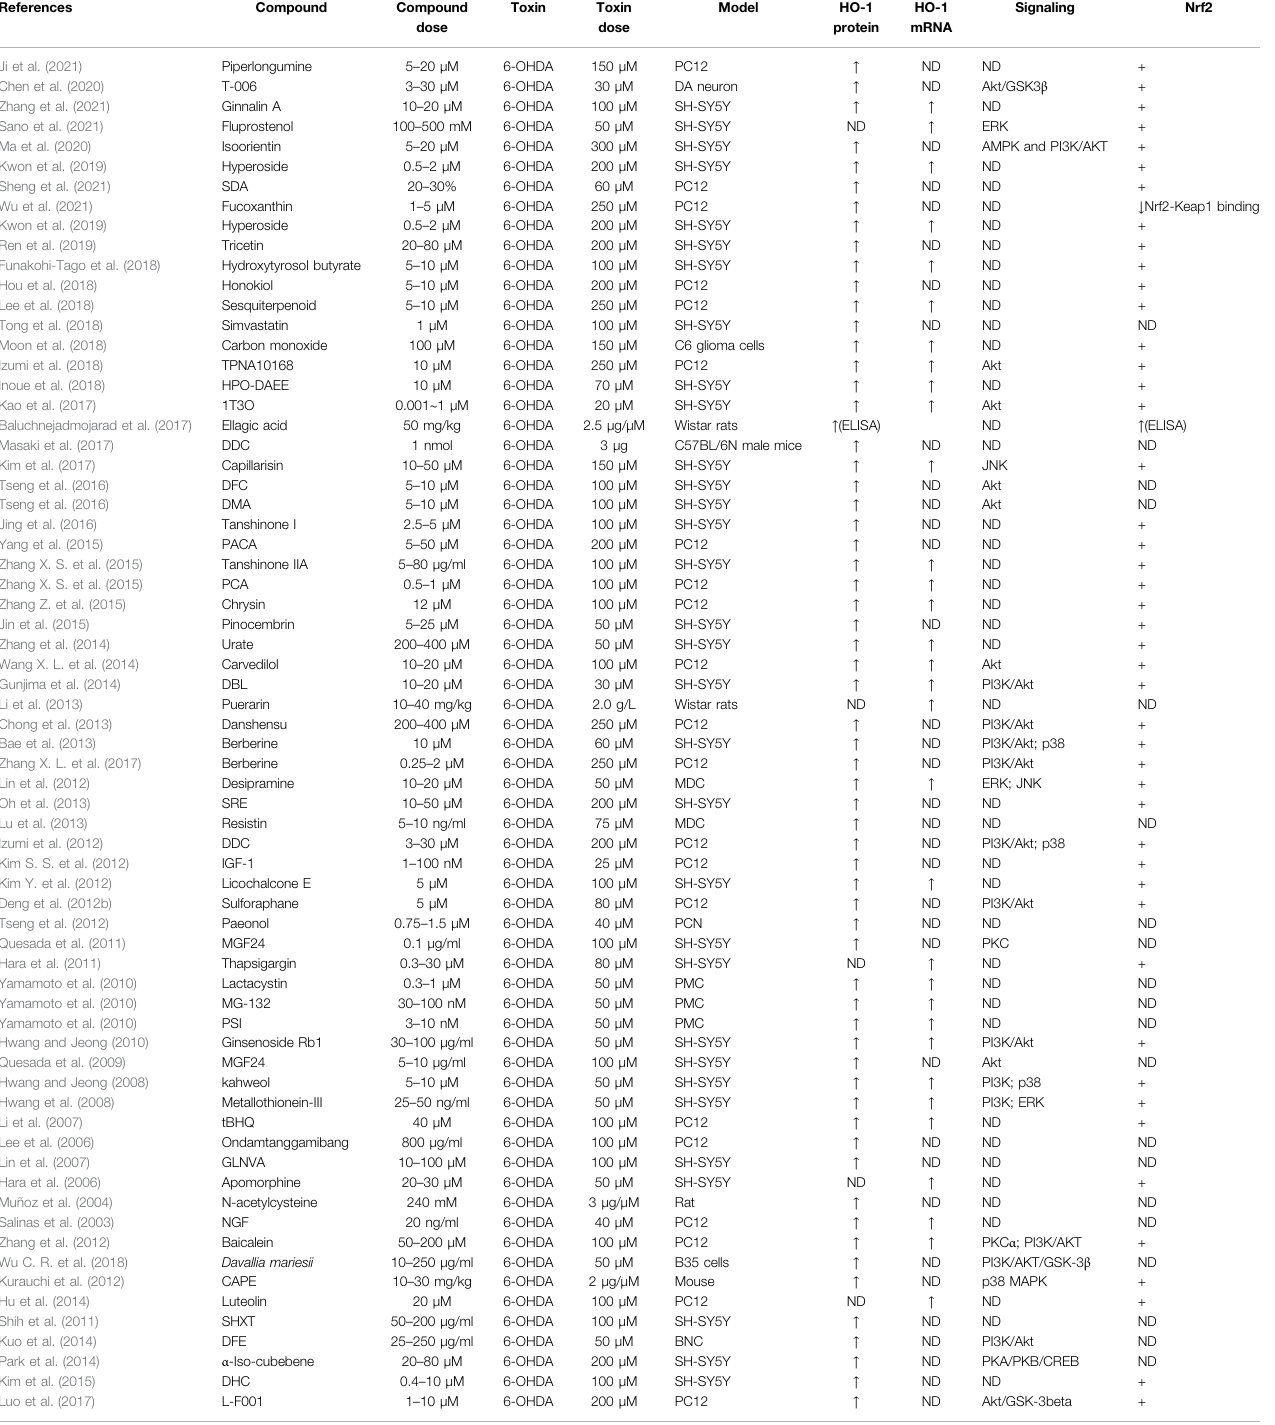
TABLE 7 | Summary of the experimental studies involving HO-1 inducer against 6-OHDA-induced PD